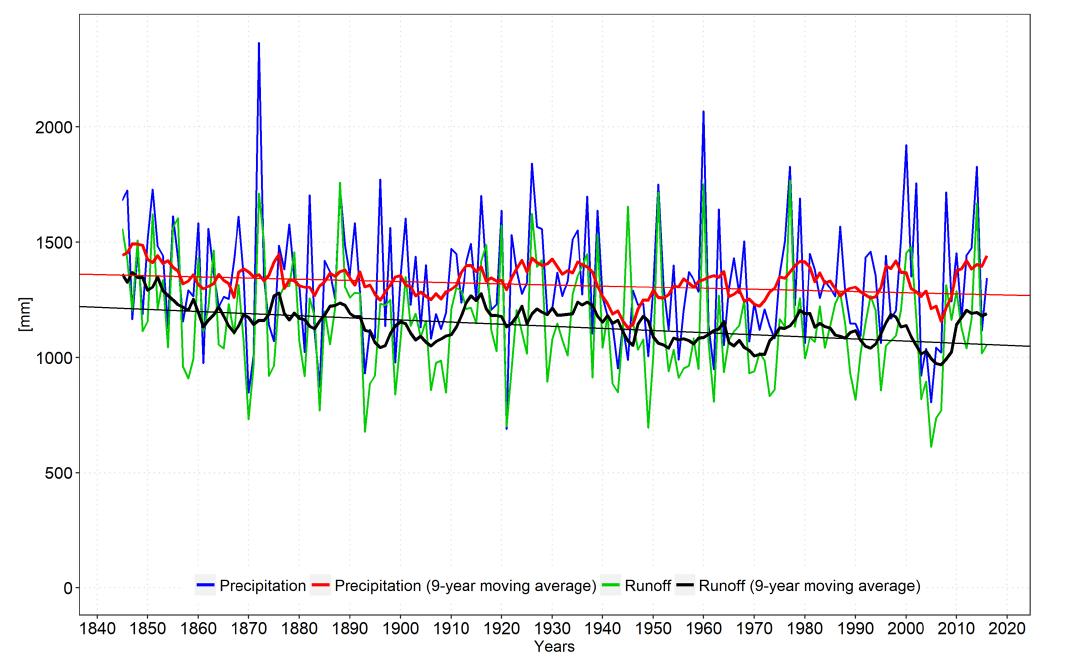
Figure 3. 1845–2016 total annual precipitation (blue line) and annual runoff (green line) records for upper Adda river catchment together with estimated Theil-Sen trends (red and black straight lines). Annual cumulates are computed considering solar